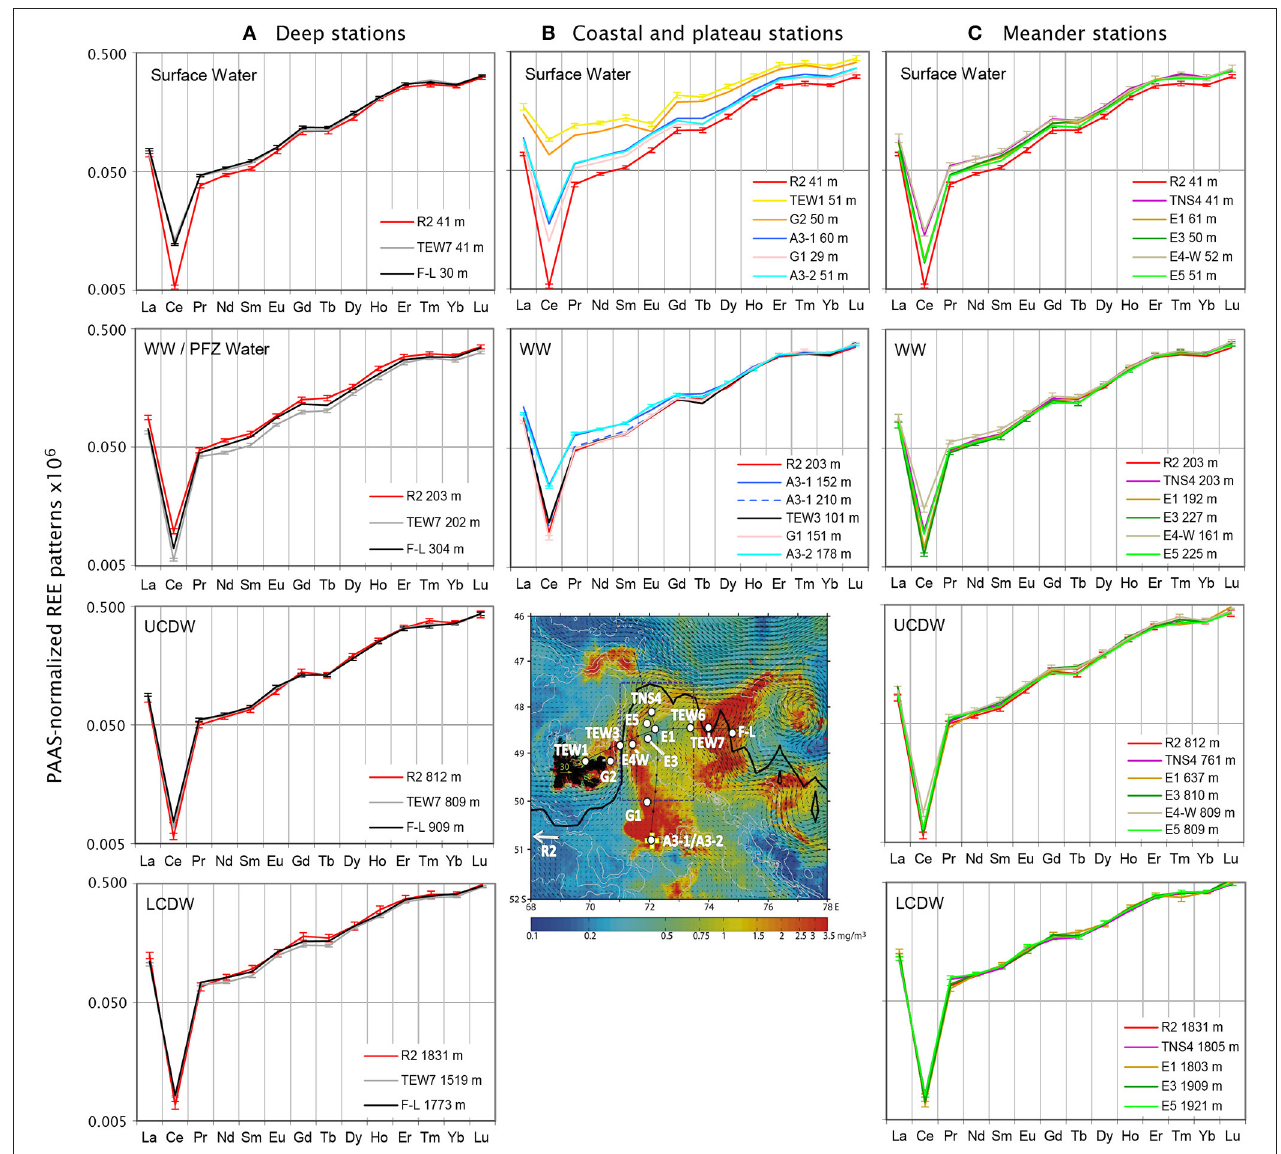
FIGURE 4 | PAAS-normalized REE patterns (PAAS, Post-Archean Australian Shale; McLennan, 1989; logarithmic scale) of the surface waters, the Winter Water (WW)/Polar Frontal Zone (PFZ) Water, the upper and the lower Circumpolar Deep Water (UCDW and LCDW), from top to bottom, for, as in Figure 3 , (A) the deep stations R2, TEW7, and F-L, in the vicinity of the PF; (B) the coastal and plateau stations TEW1, G2, TEW3, G1, A3-1, and A3-2; and (C) the stations located in the meander area TNS4, E1, E3, E4-W, and E5. As in Figure 3 , the patterns of the station R2 are reported for comparison in (B,C) (red pattern). For the sake of clarity, associated error bars are shown for some patterns only. They represent the ICP-MS method uncertainty associated with each sample